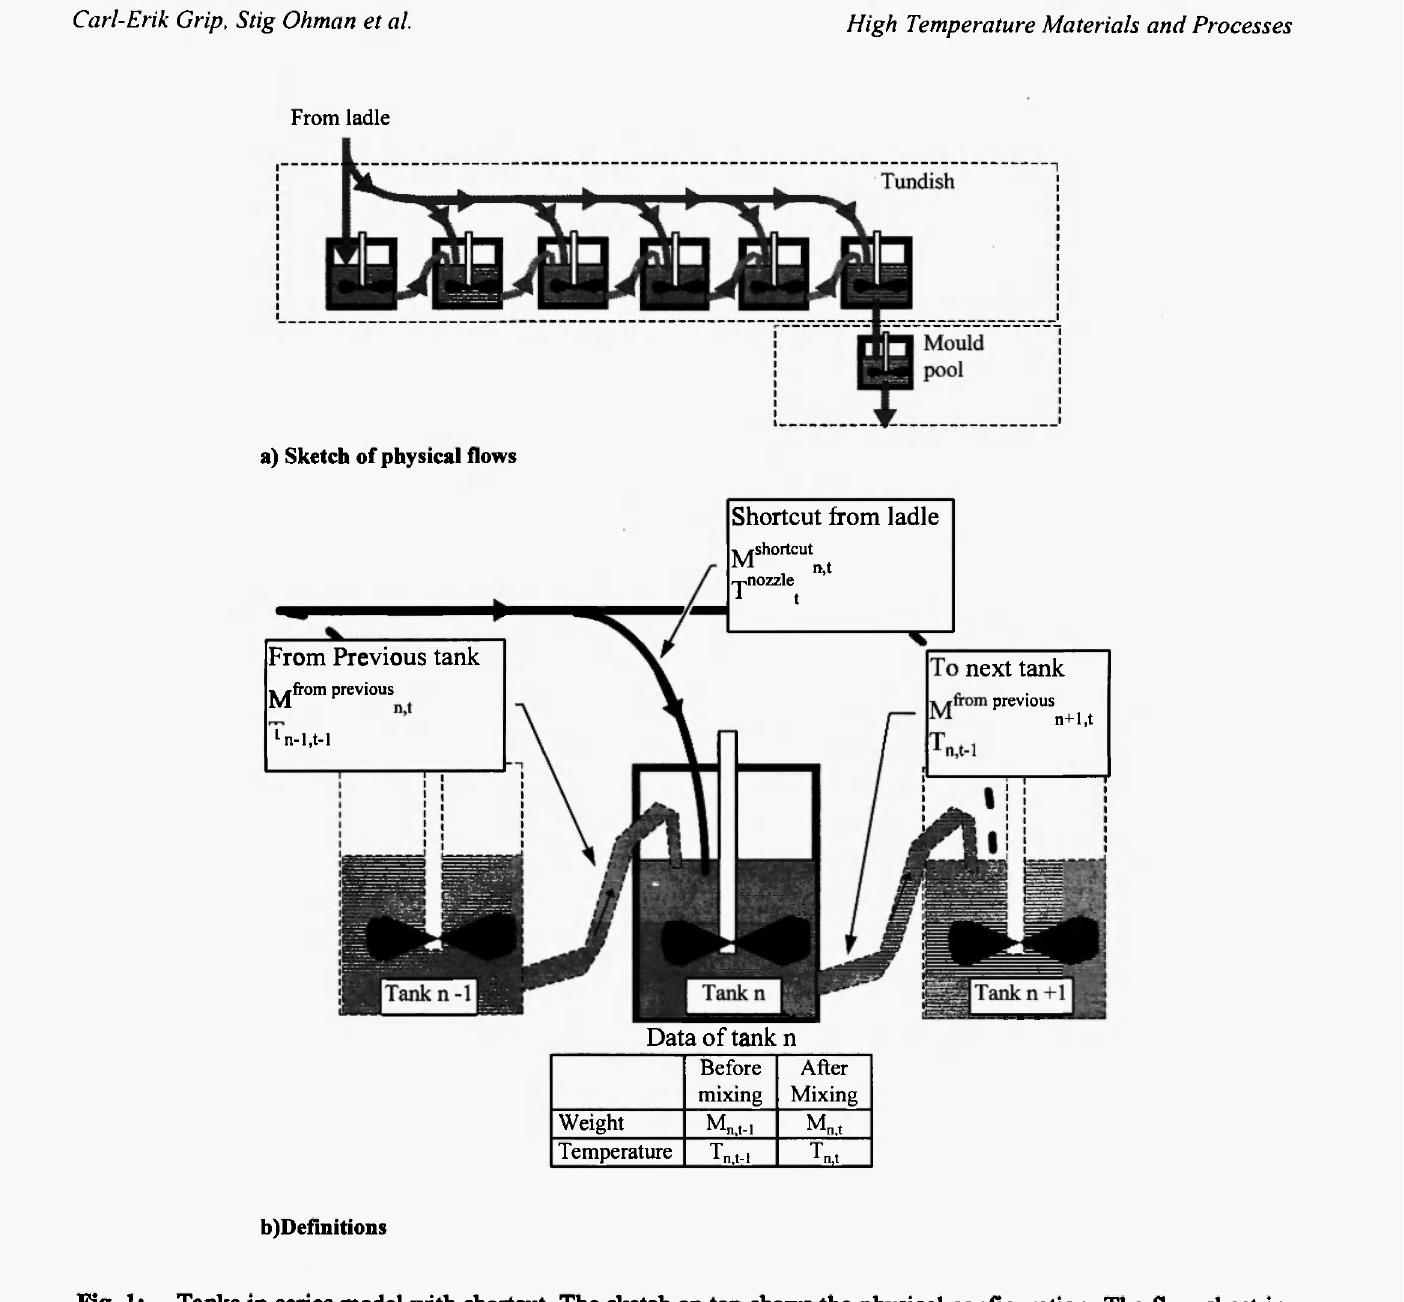
Fig. 1: Tanks in series model with shortcut The sketch on top shows the physical configuration. The flow sheet in the lower part of the figure shows the definitions used when the heat and mass balance for tank η during the time-step t is calculated. Data from the previous time-step that are used in the calculation are shown in the upper part of the flow sheet. The heat losses to wall and surface are not included in the figure.